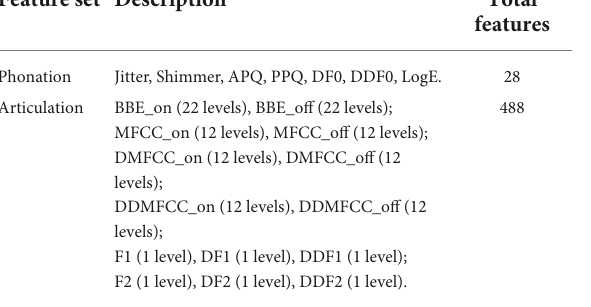
TABLE 1 Features extracted from speech signals.